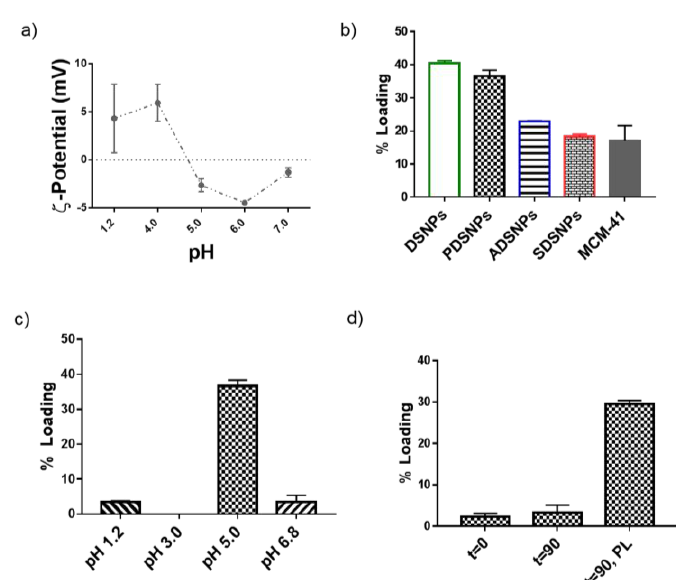
Figure 2. ( a ) ζ -potential profile of exenatide acetate at different pH confirming p I . ( b ) Loading of exenatide on different DSNPs and MCM-41, using pH 5.0 MES buffer, observed as maximum for pristine DSNPs. ( c ) Loading of exenatide on PDSNPs at different pH. ( d ) Effect of coating, chitosan in 0.1 M acetic acid solution (pH 3.8), strategies on exenatide loading. t = 0 and t = 90 shows the time interval at which chitosan was introduced into the exenatide loading solution. t = 90, PL (post loading) stands for the technique in which loaded particles were separated before the coating step. (All data are n = 3, Mean ±